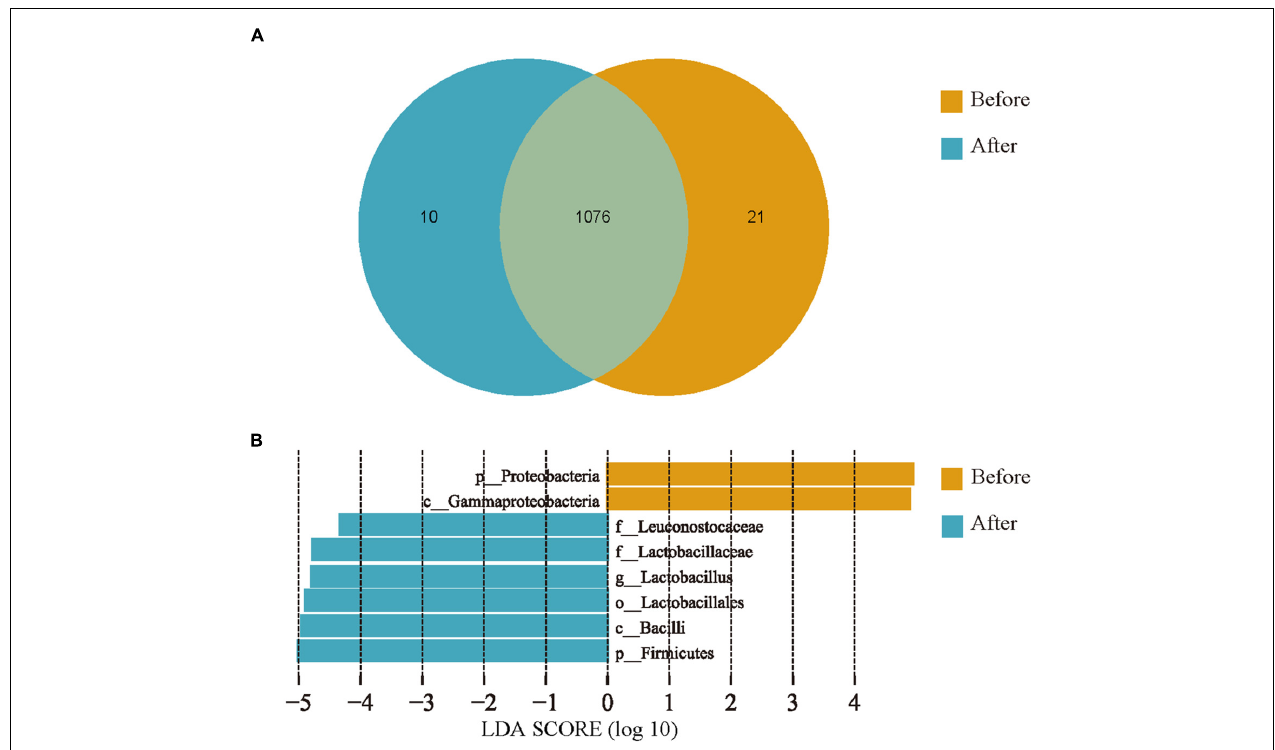
FIGURE 3 | Comparison of the unique bacteria in gut microbiota of the common kestrels before and after captivity. (A) Venn diagram showing numbers of common and unique OTUs. (B) LEfSe analysis at the genus